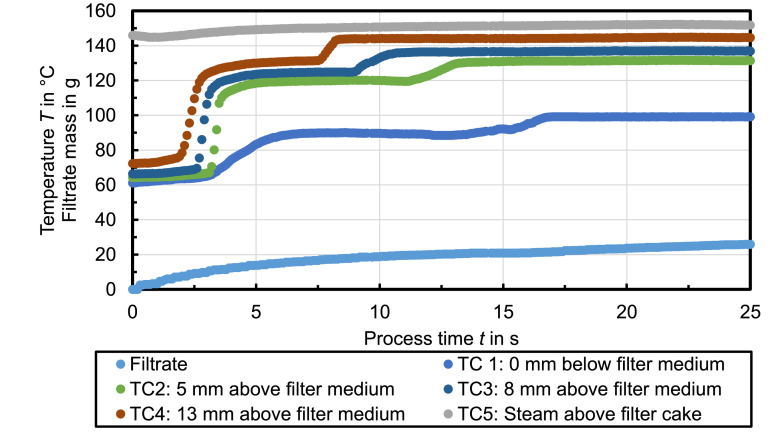
Celite®512 & n-octane (Δp = 3.7 bar, Tst = 150°C, hFC = 20 mm); RM = 26.5 %, rC = 2 × 1012 1/m²